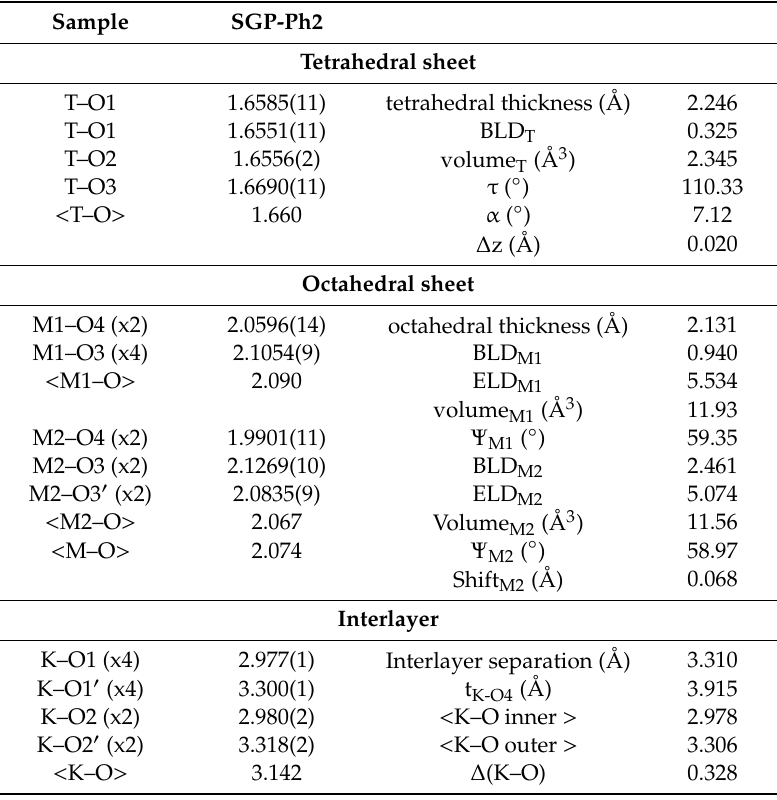
Table 7. Selected bond lengths (Å) and parameters derived from structure